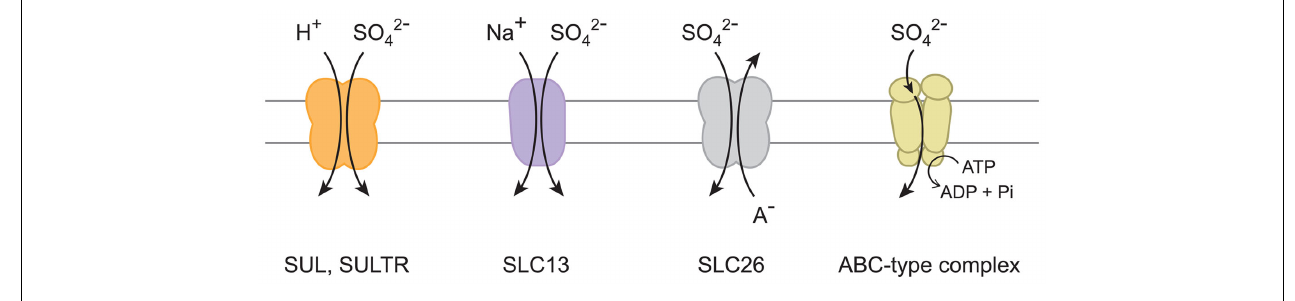
FIGURE 1 | Sulfate transport mechanisms. Proton/sulfate co-transporter, sodium/sulfate co-transporter, sulfate/anion (A − ) exchanger, and ABC-type